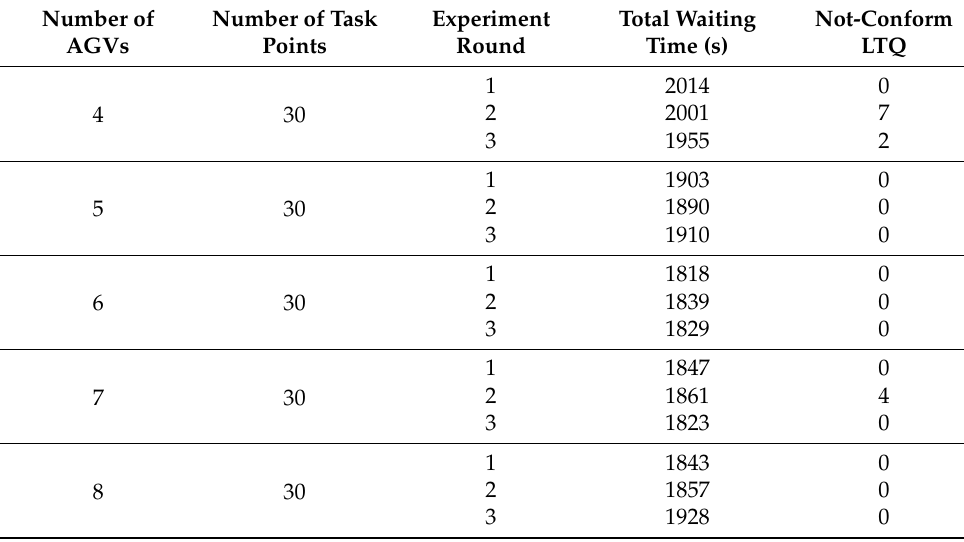
Table 9. The experimental results of different number of AGVs at 30 task